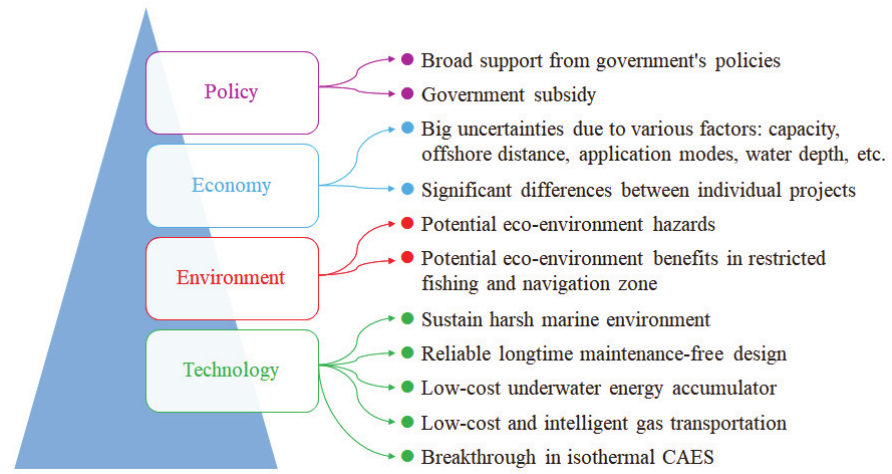
Figure 3. Challenges for developing UWCGES.